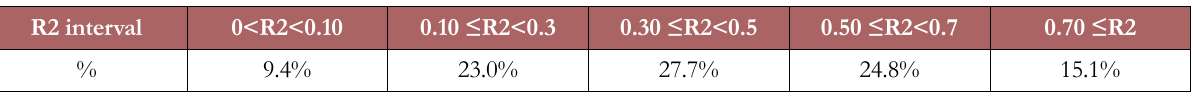
Table 9. R2 value